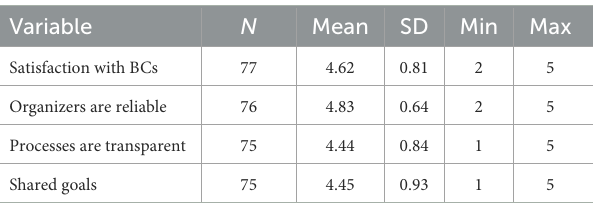
TABLE 4 Satisfaction with BCs from the producer